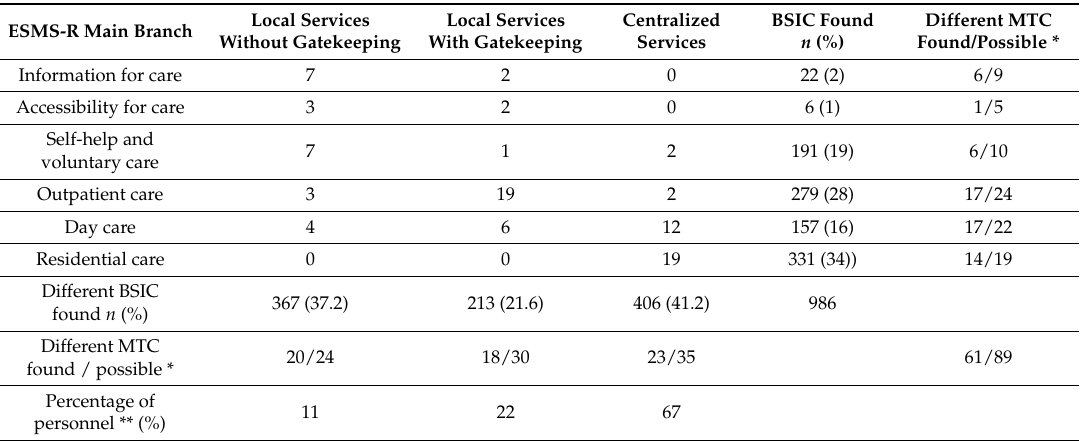
Table 1. Distribution of service units (basic stable input of care) and mental health personnel (full time equivalent) to local or/and centralized